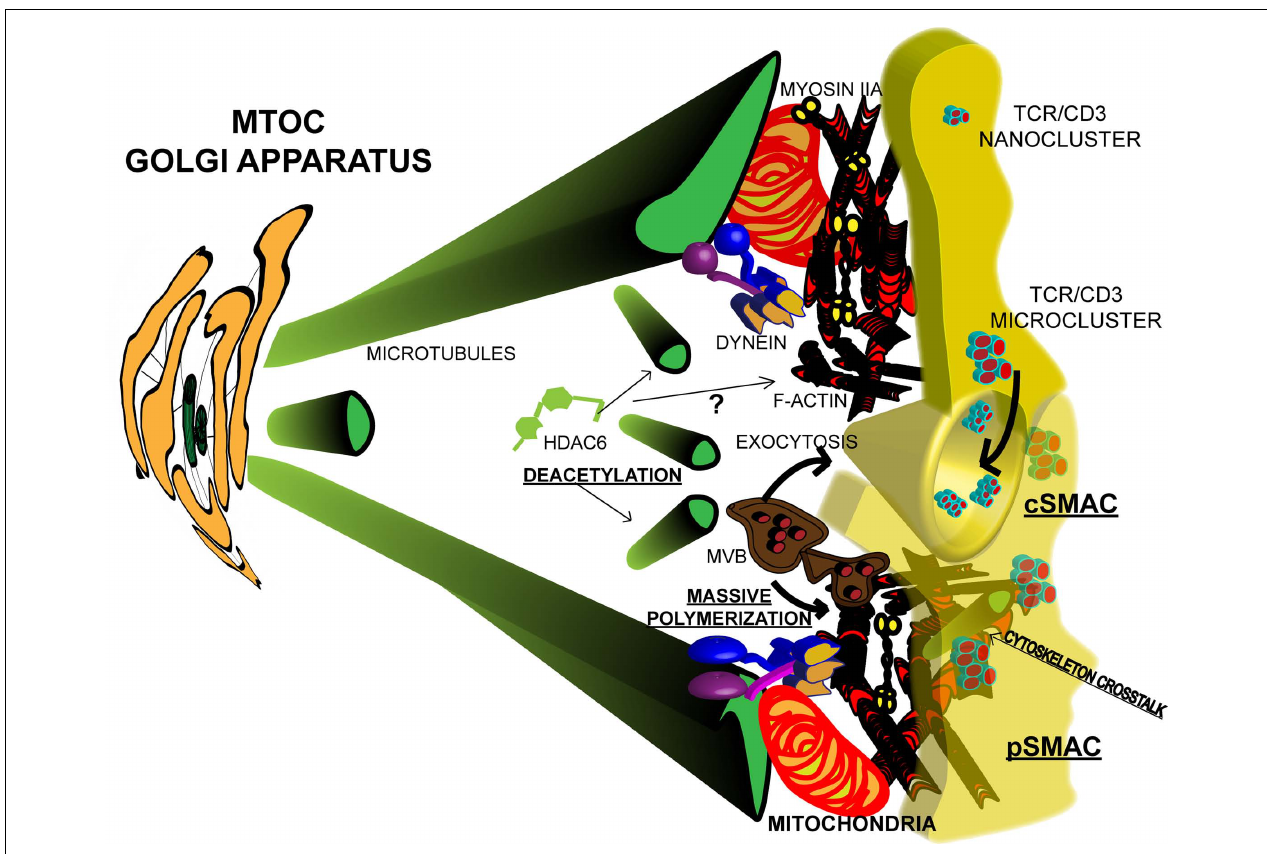
the APC through dynein/dynactin activity.The Golgi apparatus (GA) accompanies the MTOC. MVBs localize at the IS and facilitate massive polymerization of actin and exocytosis of exosomes at the immunological cleft. GA and MVBs provide the basis for polarized secretion. Mitochondria provide the energy for actomyosin contractile activity at the pSMAC. Cytoskeleton crosstalk at the IS may facilitate the movement of signaling